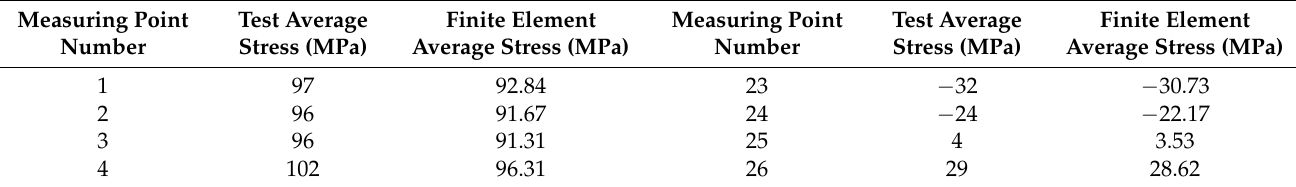
Table 3. Test value and finite element value in weld of